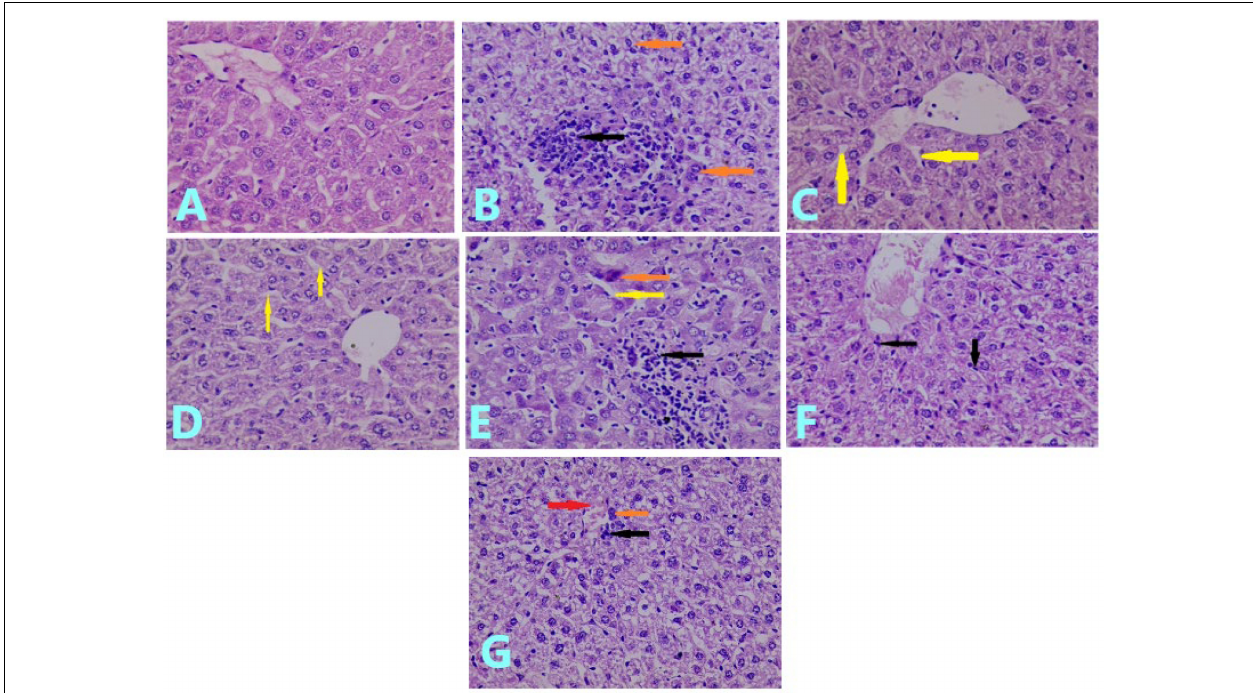
FIGURE 3 | Effects of treatments on histopathological examination of the liver tissue: (A) liver section of control group showed normal hepatocytes. (H&E; × 40). (B) Liver section of MTX-treated group showed necrosis of hepatocytes (brown arrow), infiltration of the inflammatory cell (black arrow), and prominent cellular degeneration (H&E; × 40). (C) Liver section of mice pretreated with 100 mg/kg of VC showed slight sinusoidal dilation (arrow) with mild cellular degeneration (H&E; × 40). (D) Liver section of the group pretreated with 200 mg/kg of VC showed slight sinusoidal dilation (yellow arrow) (H&E; × 40). (E) Liver section of the group pretreated with 10 mg/kg of CUR showed hepatocyte necrosis (brown arrow), sinusoidal dilation (yellow arrow), and inflammatory cell infiltration (black arrow) (H&E; × 40). (F) Liver section of the group pretreated with 20 mg/kg of CUR showed cellular degeneration with mild infiltration of inflammatory cells (black arrow) (H&E; ( × 40). (G) Liver section of mice pretreated with VC and CUR showed slight inflammatory cell infiltration (black arrow), necrotic cells (brown arrow), and slight congestion (red arrow) (H&E; ×